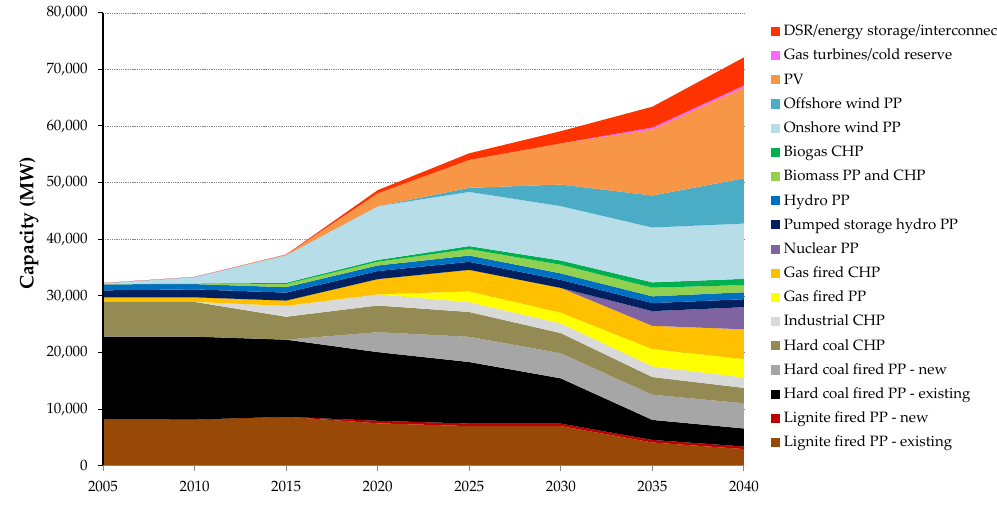
Figure 11. Installed capacity in Poland in the period 2005–2040 [42].